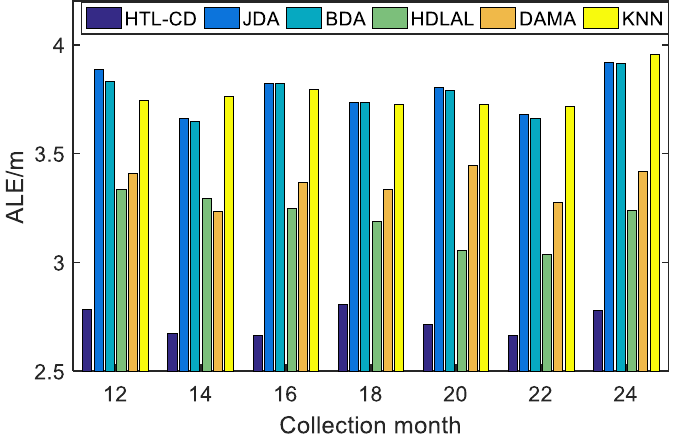
Figure 6. Comparison of the positioning performances with totally different APs.